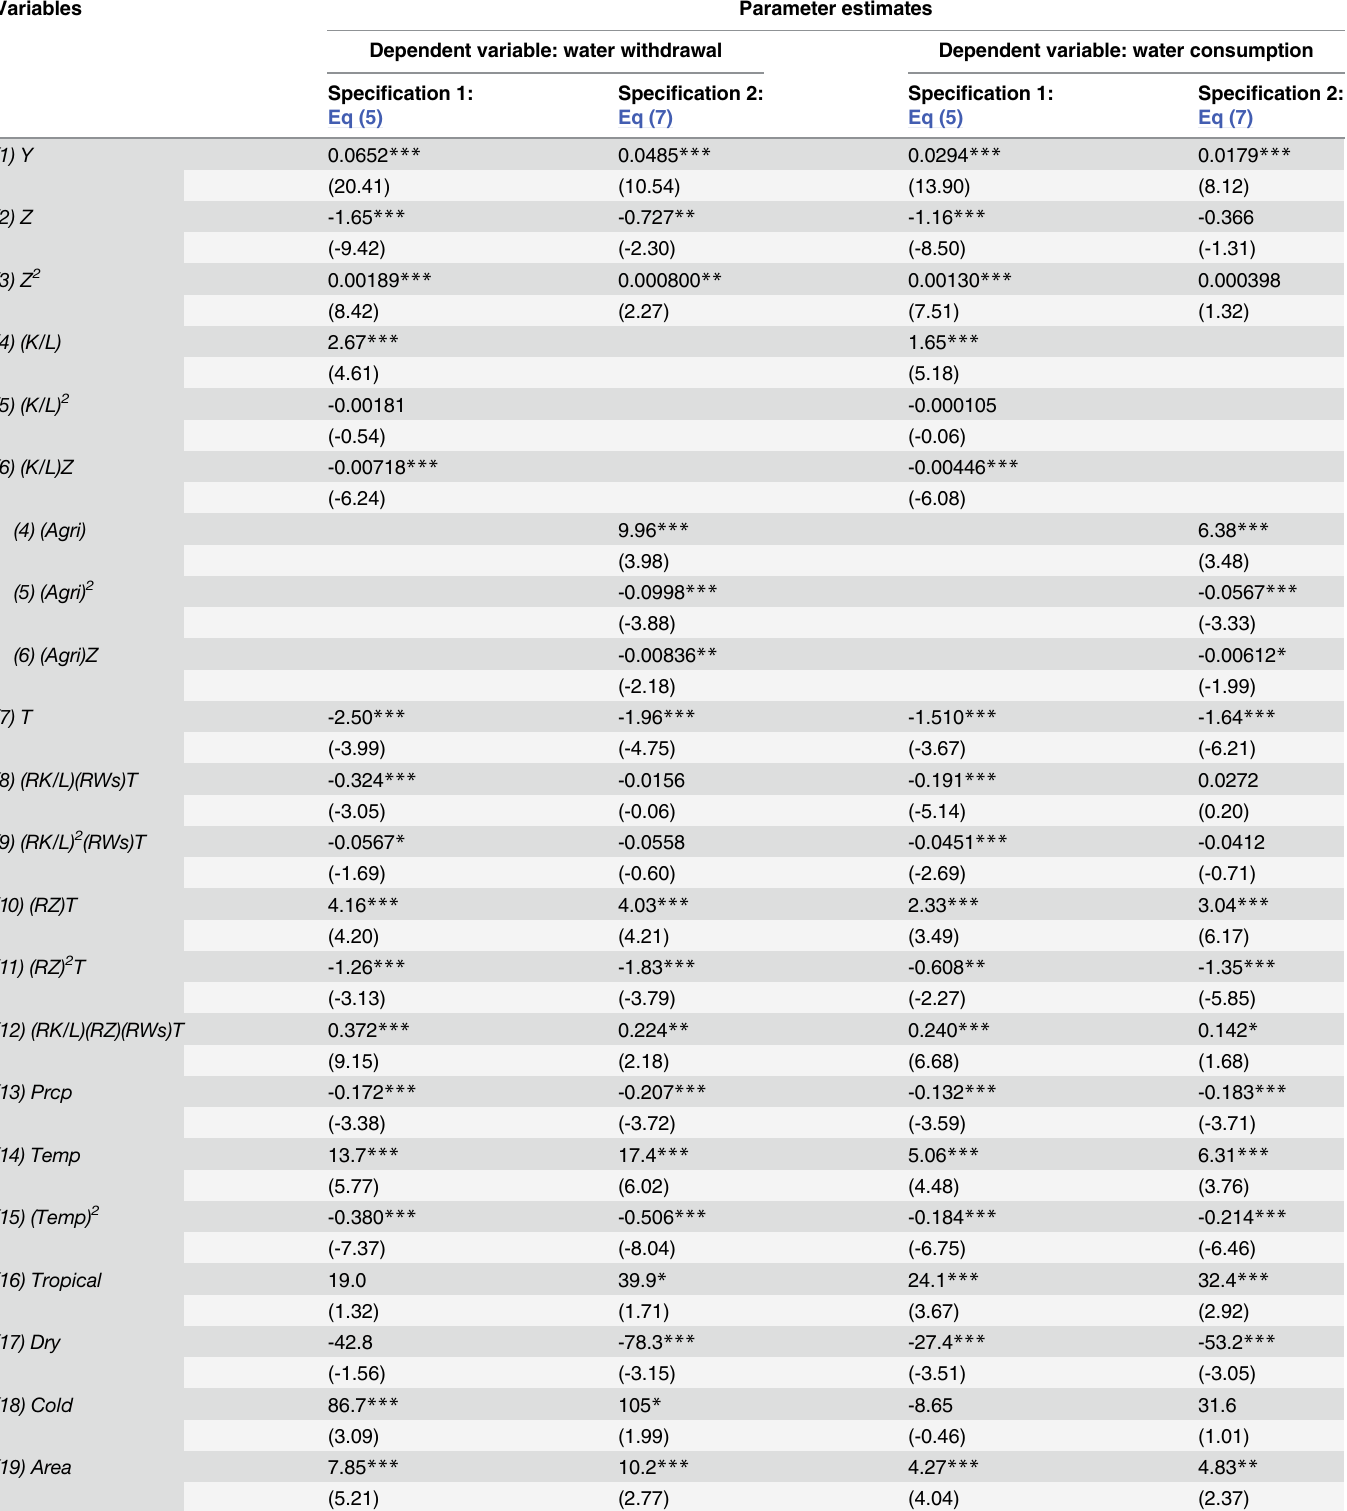
Table 5. Estimates in Water Use